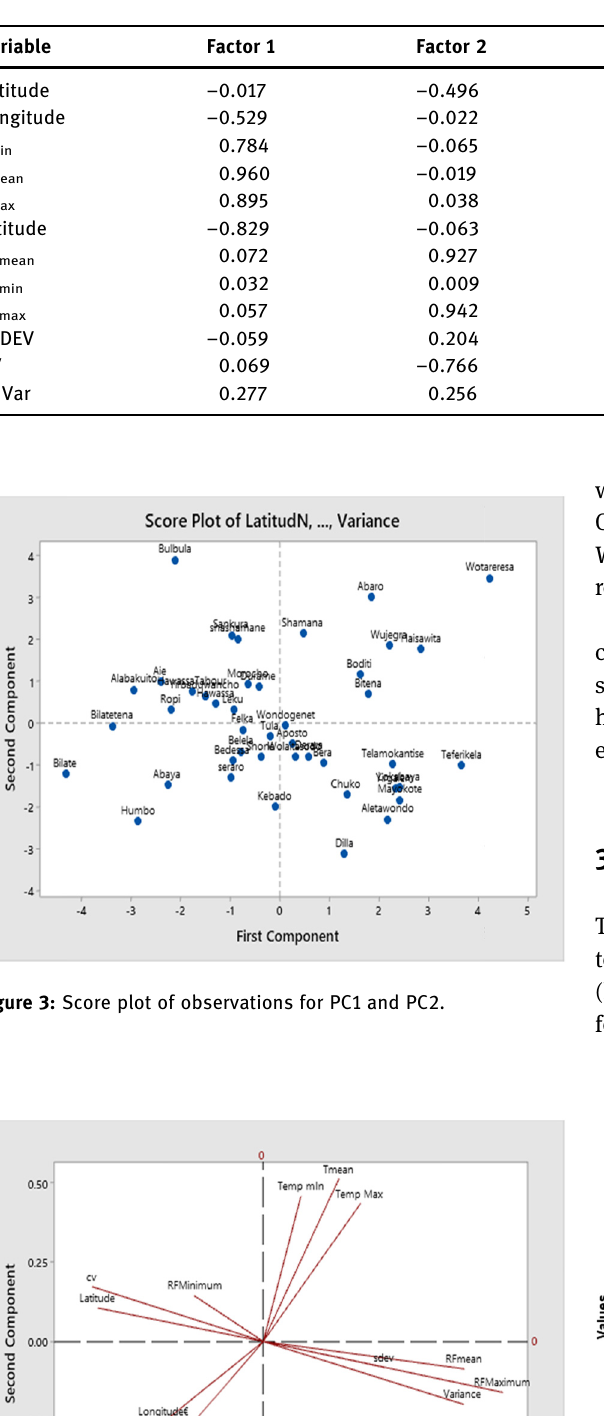
Table 4: Sorted rotated factor loadings and communalities for FMAM season